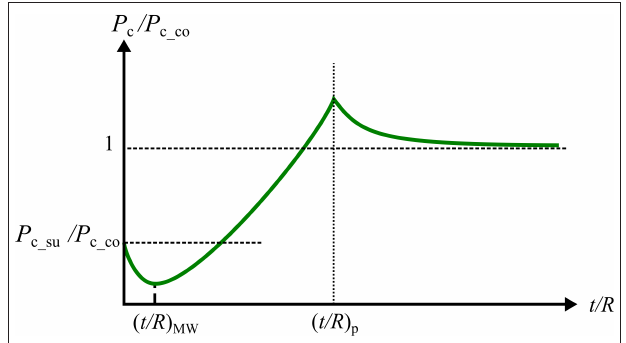
FIGURE 1 | Schematic of the dimensionless critical load, P c / P c_co , vs. dimensionless coating thickness, t/R , for a single-layer coated sphere flattened by a rigid flat.